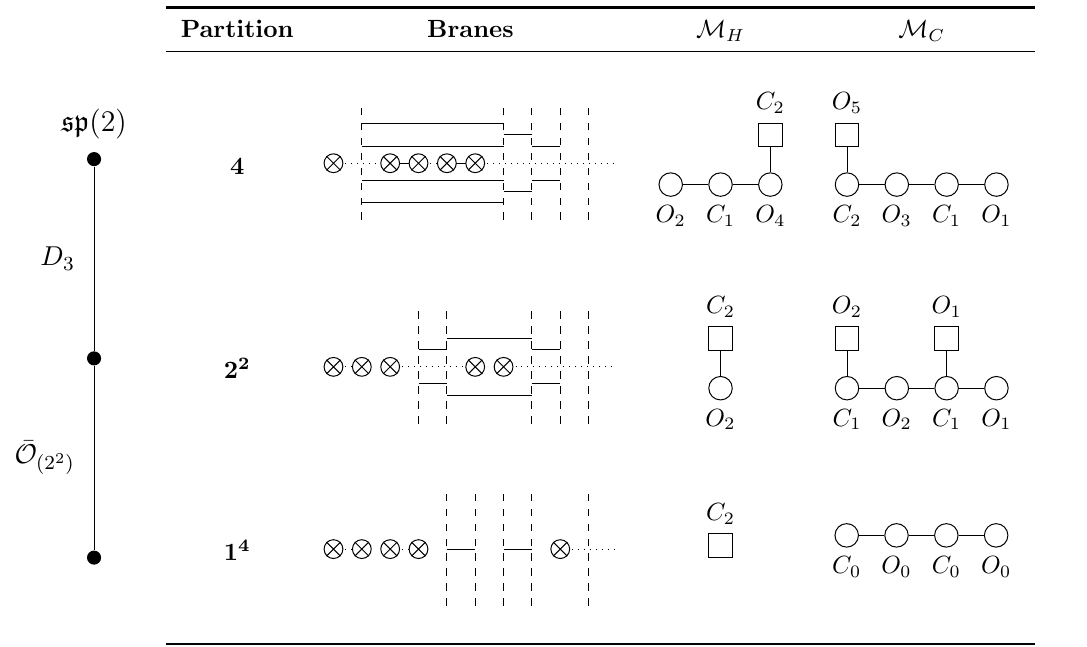
Table 5. Summary of Kraft-Procesi transitions for the nilpotent orbits of sp (2). The brane systems in the middle depict models whose Higgs branch is the closure of the nilpotent orbit labelled by each Partition . The column M H contains the quivers of such models, with M H = (cid:22) O (cid:21) . The column M C depicts the quivers of the models obtained after performing S-duality transformation on the Brane systems, they are predicted to have M C = (cid:22) O (cid:21) . The C 0 and O 0 gauge nodes have been left in this column to highlight the e(cid:11)ect that the transition has on these quivers: the (cid:13)avor nodes move along a (cid:12)xed structure of gauge nodes, while the rank of the gauge nodes